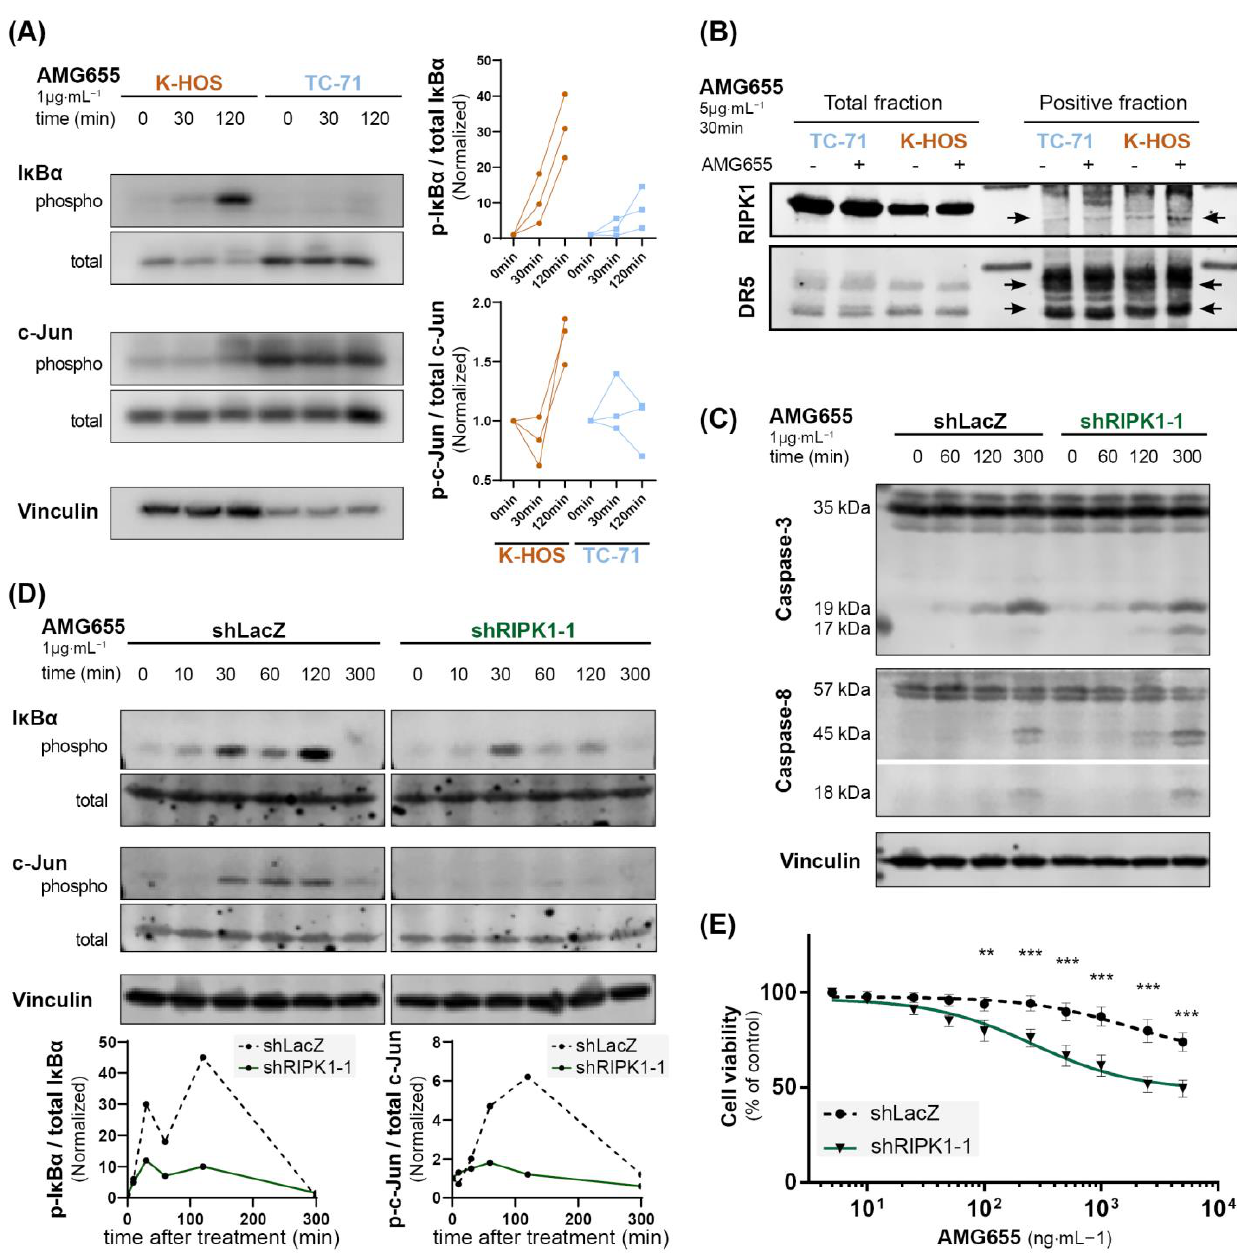
Figure 3. The inhibition of non-apoptotic pathways in K-HOS cells by complex II disruption through RIPK1 knockdown leads to an increased caspase-3 cleavage and AMG655 re-sensitiza- tion. ( A ) Kinetic of IκBα and c -Jun phosphorylation in K-HOS and TC-71 cell lines upon 1 ug ⋅ mL −1 of AMG655 treatment (left panels). Quantification of 3 independent experiments, normalized to to- tal form and basal signal (right panels). ( B ) Immunoprecipitation of DR5 using AMG655 antibody to explore the recruitment of RIP1K in the protein complex. ( C ) Kinetics of caspase-8 and caspase-3 cleavages in K-HOS cell line transduced with shLacZ or shRIPK1-1 after 1, 2, and 5 h treatment with 1 µg ⋅ mL −1 of AMG655 analyzed by Western blot. Vinculin was used as a loading control. ( D ) Kinetic of IκBα and c -Jun phosphorylations in K-HOS shLacZ and shRIPK1-1 cell lines upon treatment with 1 µg ⋅ mL −1 of AMG655 (top panels) and quantification normalized to total form and basal signal (bottom panels). ( E ) shLacZ and shRIPK1-1 K-HOS cells were cultured for 72 h in the presence of increasing concentrations of AMG655 (** p < 0.01 *** p < 0.001).